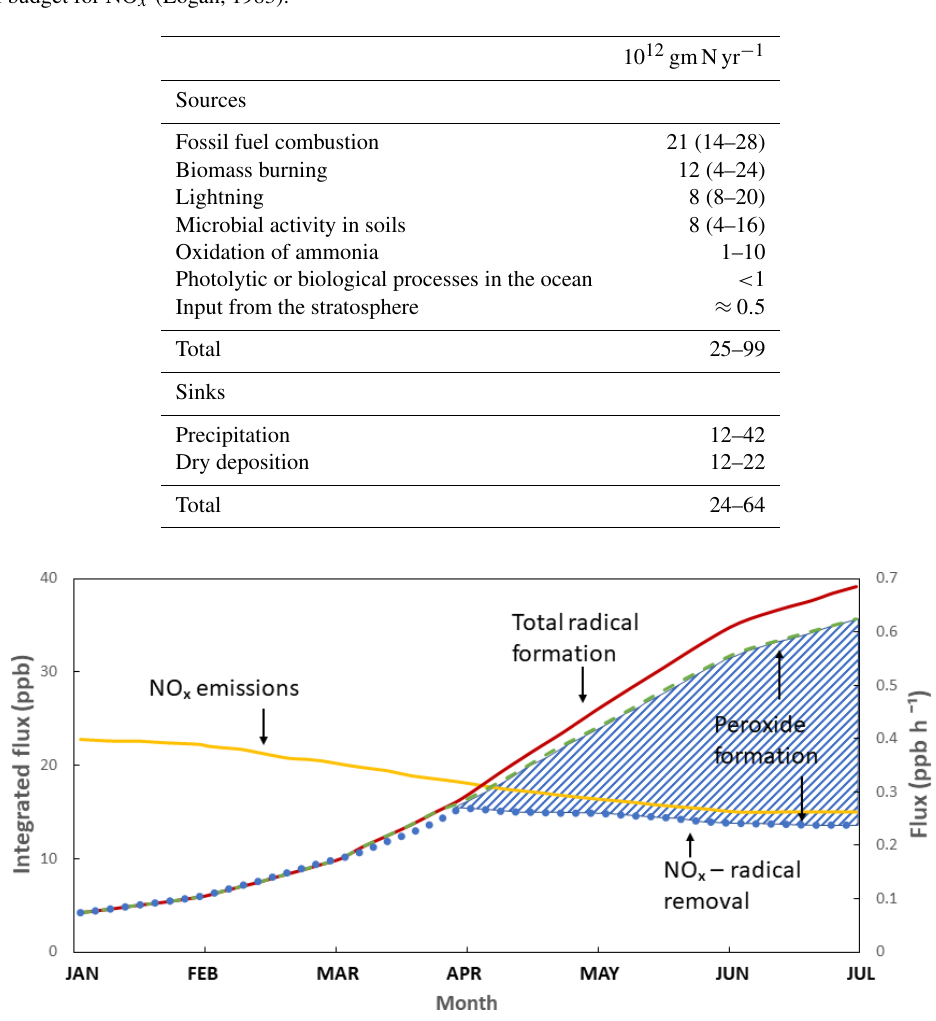
Table 3. A global budget for NO x (Logan, 1983).